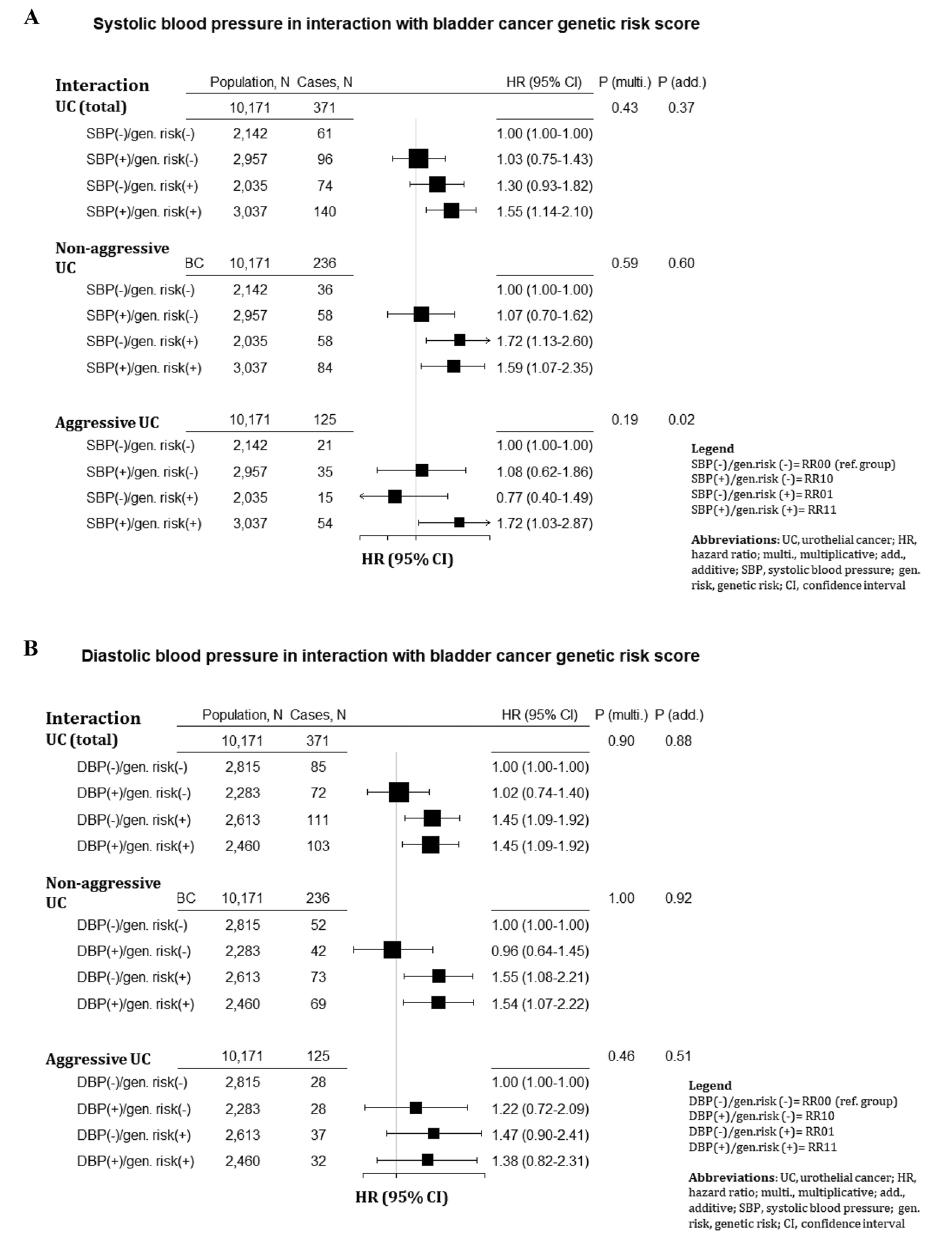
Figure 3. Hazard ratios (95% confidence interval) by groups of: ( A ) systolic blood pressure (SBP); and ( B ) diastolic blood pressure (DBP), and bladder cancer genetic score, including their multiplicative and additive interaction p-values, in relation to risk of urothelial cancer outcomes in the Malmö Diet and Cancer Study (MDCS; N participants = 10,339; N cases = 371). Hazard ratios were calculated by Cox regression with attained age as the underlying time scale, with adjustment for smoking, BMI, physical activity and level of education. The Relative excess risk for interaction (RERI) was calculated as RR 11 -RR 10 -RR 01 + 1, where: RR 00 (or 1, reference group) represented individuals with normal SBP/DBP (< 140/90) and lower 50% of the BC genetic risk; RR 10 represented those with high SBP/DBP (≥ 140/90) and lower 50% of BC genetic risk; RR 01 represented those with normal SBP and upper 50% of BC genetic risk; and RR 11 representing those with high SBP and upper 50% of BC genetic risk. The confidence intervals for RERI were obtained using the delta method, the p-value for additive interaction (p-value [add.]) was obtained from the RERI model. Multiplicative interaction was calculated using the likelihood ratio test (LR test). P-value (multi.) is the p-value for the multiplicative interaction obtained from the likelihood ratio